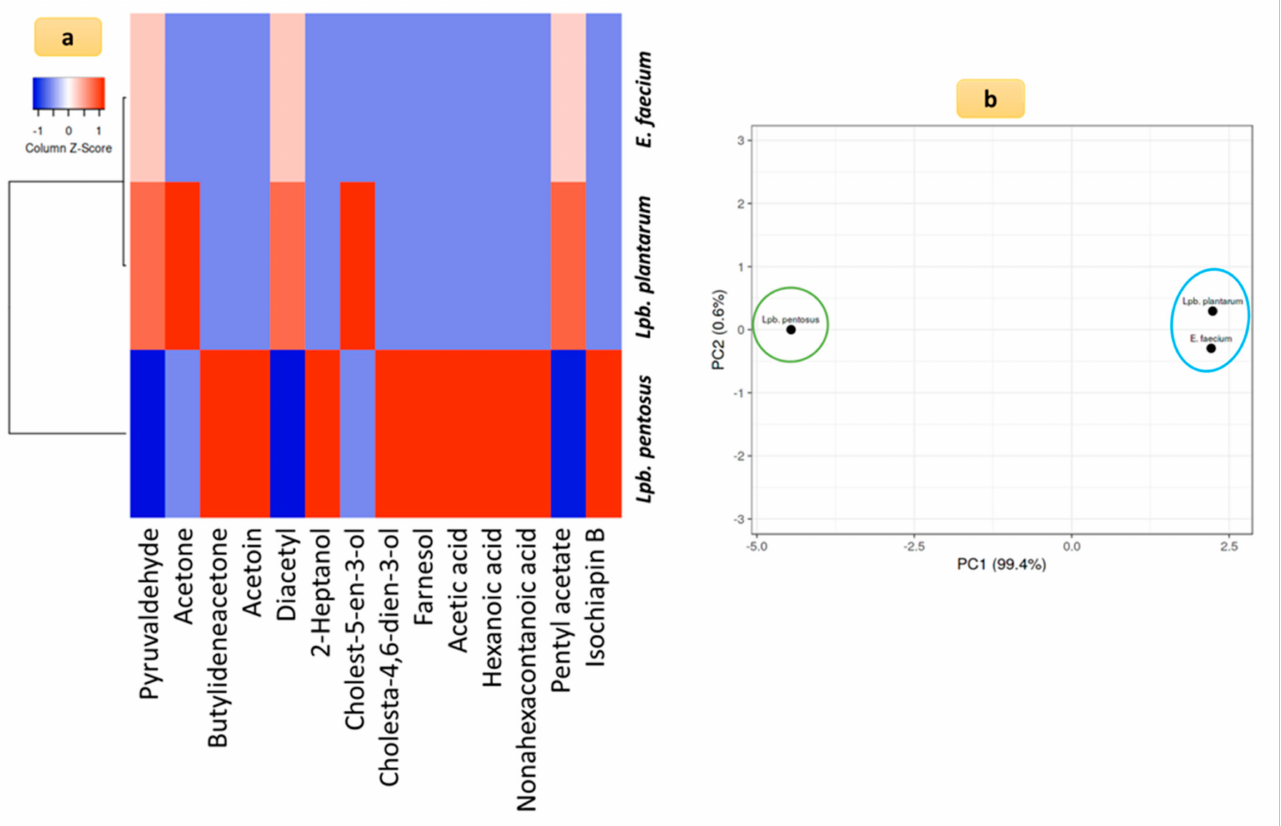
Figure 5. Heatmap visualization of the volatile compounds of fermented milk samples based on the hierarchical clustering analysis ( a ). Principal component analysis (PCA) of fermented milk based on their volatile compounds ( b